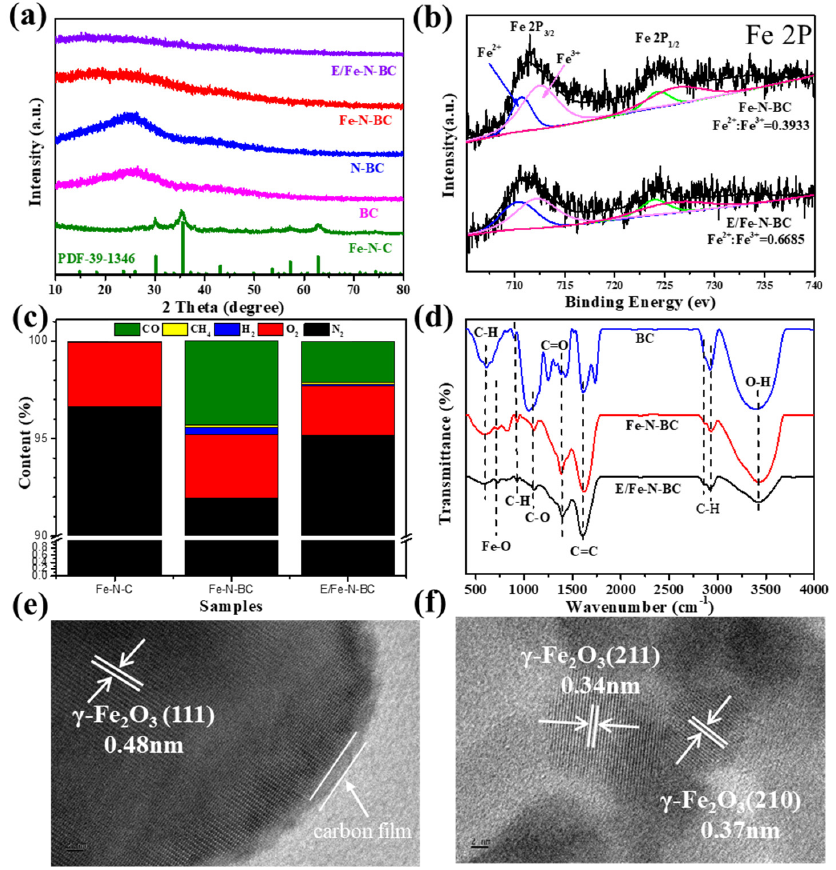
Figure 2. The XRD pattern of BC, N–BC, Fe–N–BC, E/Fe–N–BC, and Fe–N–C ( a ). The XPS spectra of Fe 2P, Fe–N–BC, and E/Fe–N–BC ( b ). The gas component during the synthesis of Fe–N–C, Fe–N– BC, and E/Fe–N–BC ( c ). The FT–IR of Fe–N–BC and E/Fe–N–BC ( d ). The TEM images of E/Fe–N– BC ( e , f ).